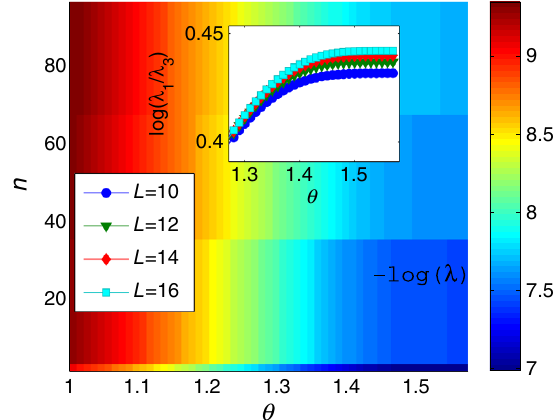
FIG. 25. The behavior of the first 100 eigenvalues λ ( n is on n the y axis) of the reduced density matrix of half infinite cylinders ρ 16 . We plot them as a 1 = 2 defined in Fig. 22(b) with L ¼ function of θ ( x axis). θ varies in the crossover range 1 ≤ θ ≤ π = 2 identified during the analysis of the topological entropy in Fig. 24. The entanglement spectrum presents clear plateaux, footprints of RK wave functions. Nevertheless, its lower part does not seem to detect the phase ’ s transition. The first Schmidt gap is identically 0 everywhere (there are two degenerate eigenvalues), and the second Schmidt gap increases while approaching the transition (inset in the figure) for all the L ¼ 10 ; … ; 16